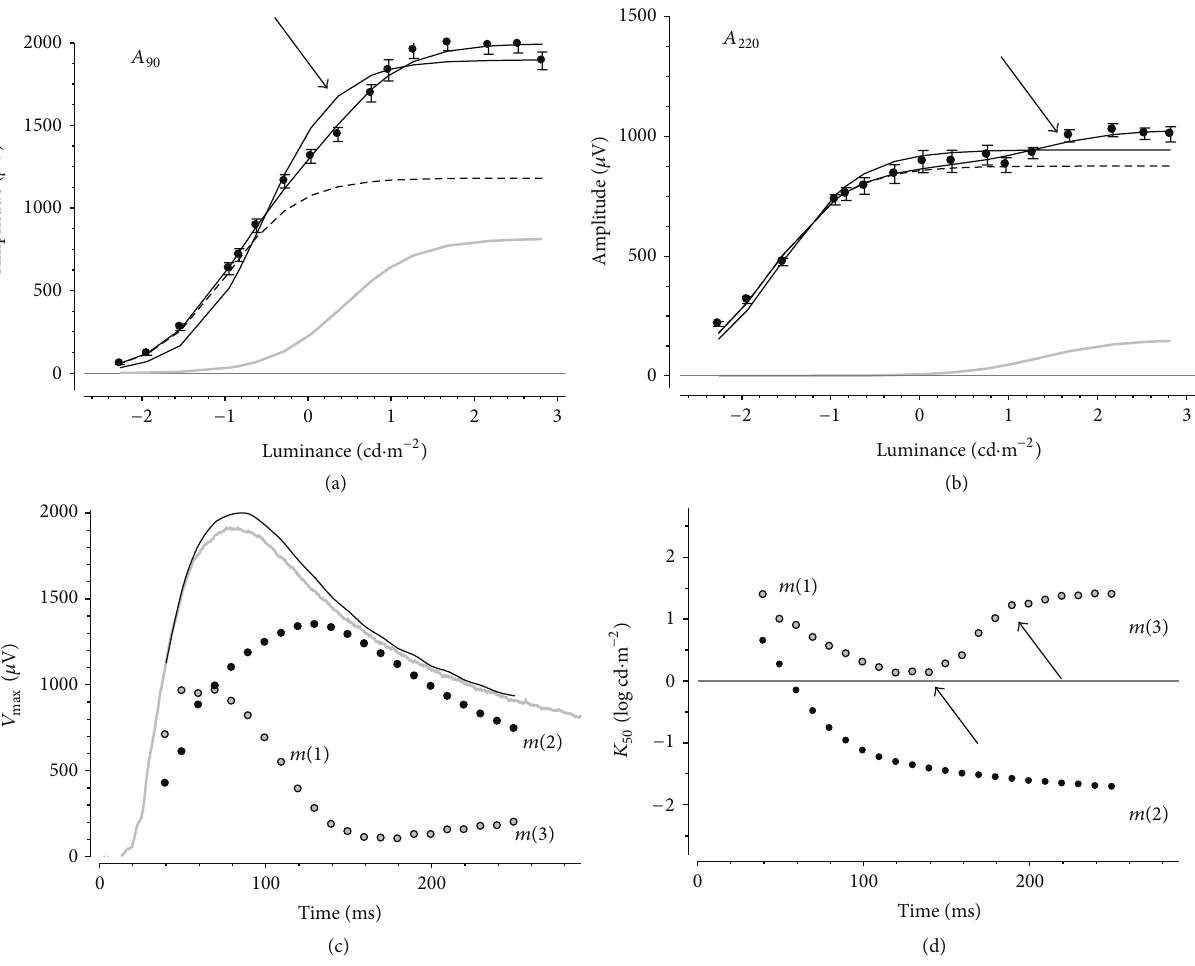
Figure 4: Modeling contributions to rat PII during a light step. Average amplitudes ( ± SEM) as a function of luminance at different fixed times (90 and 220 ms) after stimulus onset. (a) and (b) show a single hyperbolic function fit to the data (thick grey line). Arrows indicate the possible presence of a secondary mechanism at brighter intensities. A combination of two hyperbolic functions (grey trace and dashed trace) provides a better fit to the data than a single hyperbolic function. The black trace shows the sum of the two hyperbolic functions. The optimized 𝑉 max (c) and 𝐾 50 (d) parameters are plotted as a function of time for the two hyperbolic functions. (c) shows the combined amplitude for the two hyperbolic functions (black trace) compared with the actual waveform for the 2.82 logcd ⋅ m −2 (grey trace) stimulus. The arrows in (d) indicate changes in 𝐾 50 , which are likely to represent a transition between